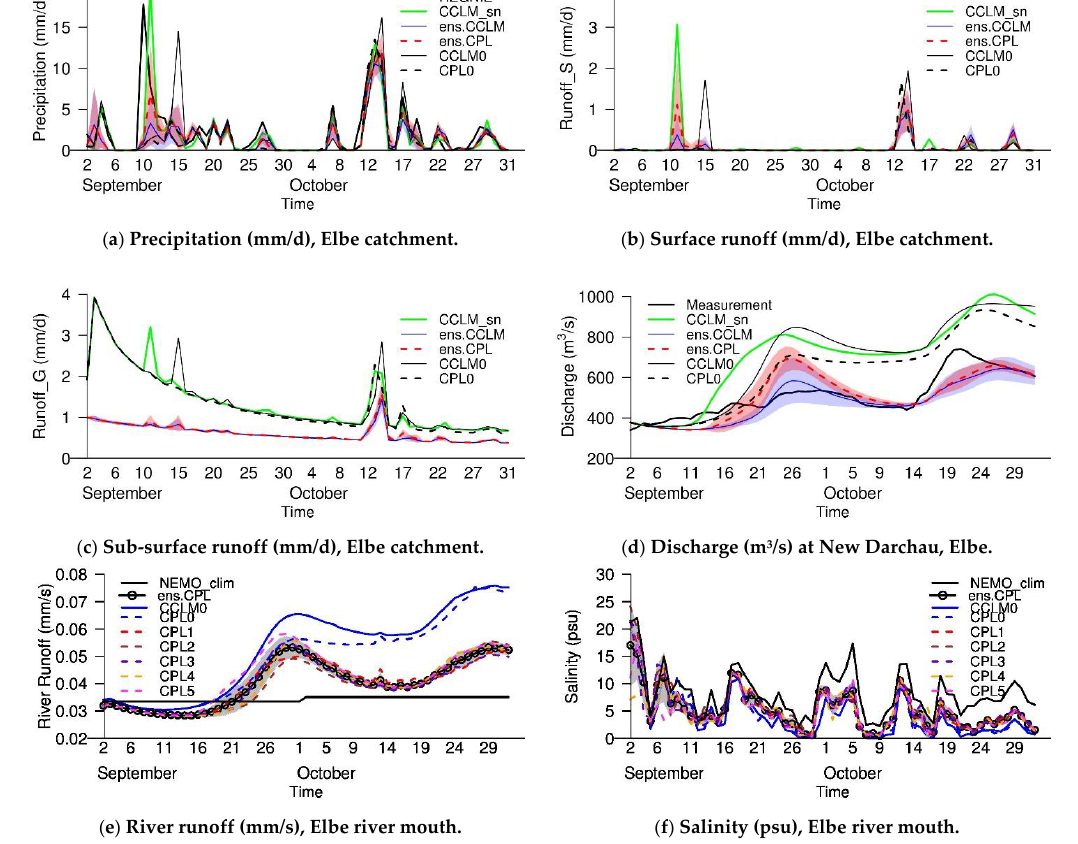
Figure 17. Daily ( a ) precipitation ( mm/d), ( b ) surface runoff (mm/d), and ( c ) sub-surface runoff (mm/d) averaged over the Elbe catchment from CCLM, ( d ) Elbe river discharge (m 3 /s) at New Darchau from HD, ( e ) river runoff (mm/s) at the Elbe river mouth on the NEMO grid, and ( f ) salinity (psu) near the Elbe river mouth from NEMO. Shaded areas indicate the spreads of stand-alone CCLM and coupled AHOI experiments, respectively. REGNIE precipitation and observed discharge are shown in ( a ) and ( d ). NEMO_clim in ( e , f ) is the stand-alone NEMO run using climatological runoff data. Time period: 1 September–31 October 2013.